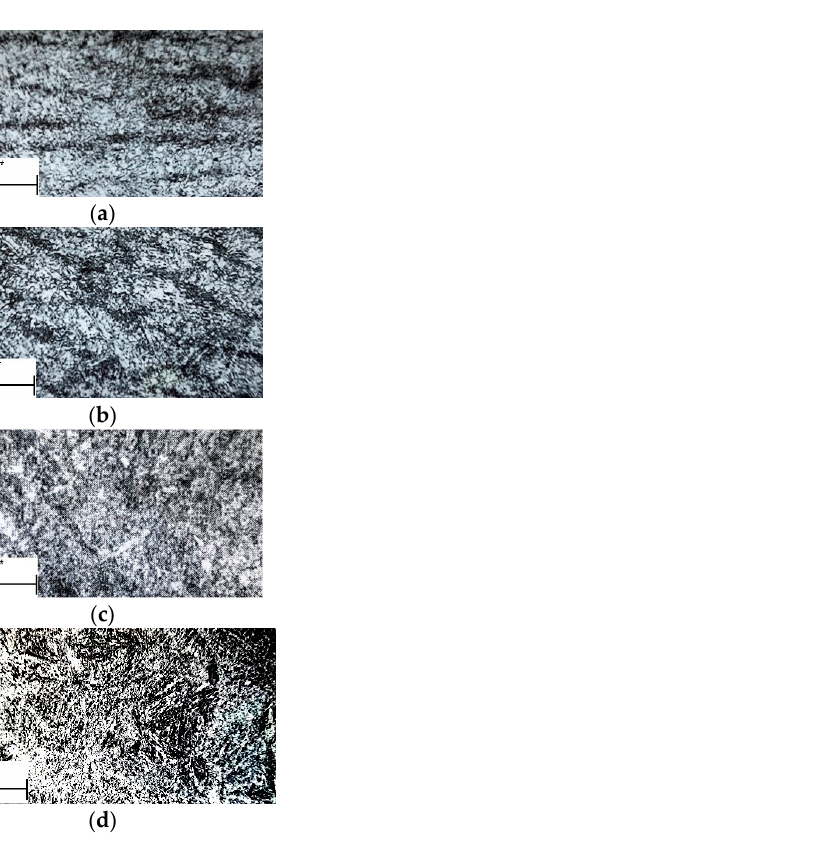
Figure 9. The structure of the weld metal of the welded joint made of the steel 25H2NMFA (Figure 7): ( a )—template 1, ( b )—template 2, ( c )—template 3, ( d )—original metal. ×400. *—mkm. ( a )—template 1, ( b )—template 2, ( c )—template 3, ( d )—original metal. × 400.